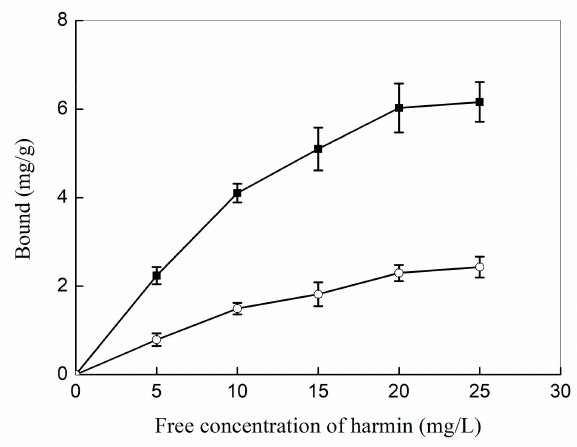
Figure 7. Equilibrium binding of haa-MIP (square) and NIP (circular) nanospheres toward harmine in